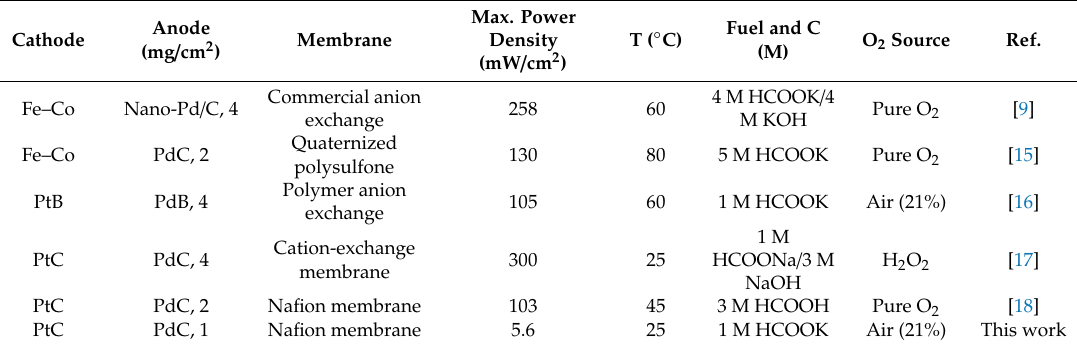
Table 4. Comparison of obtained results with literature